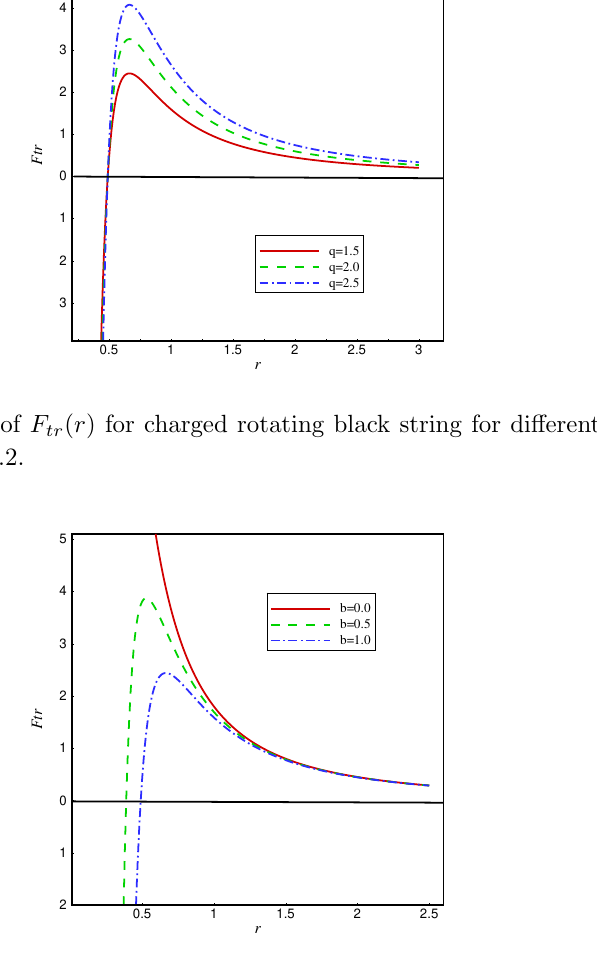
Figure 8 . The behavior of F tr ( r ) for charged rotating black string for di(cid:11)erent parameter b . Here we have taken q = 1 : 5, (cid:3) = 2, (cid:4) = 1 :